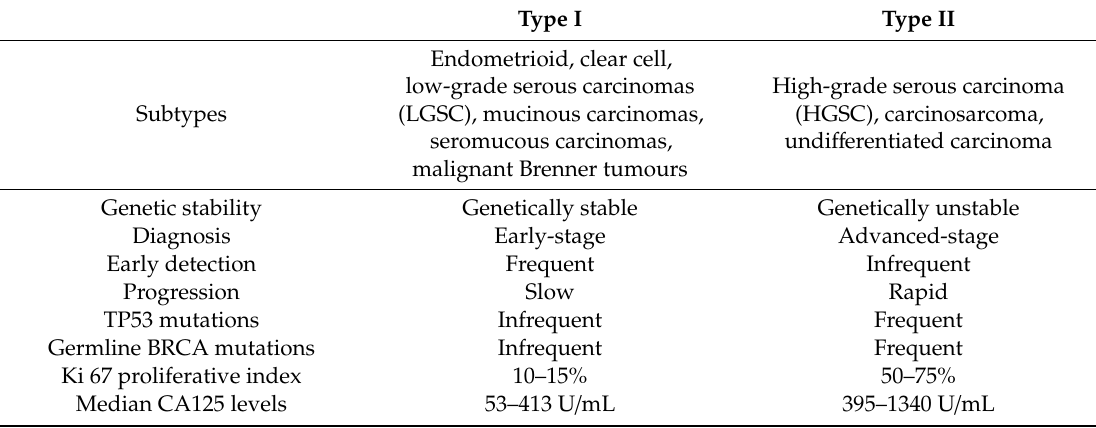
Table 1. Type I versus type II ovarian